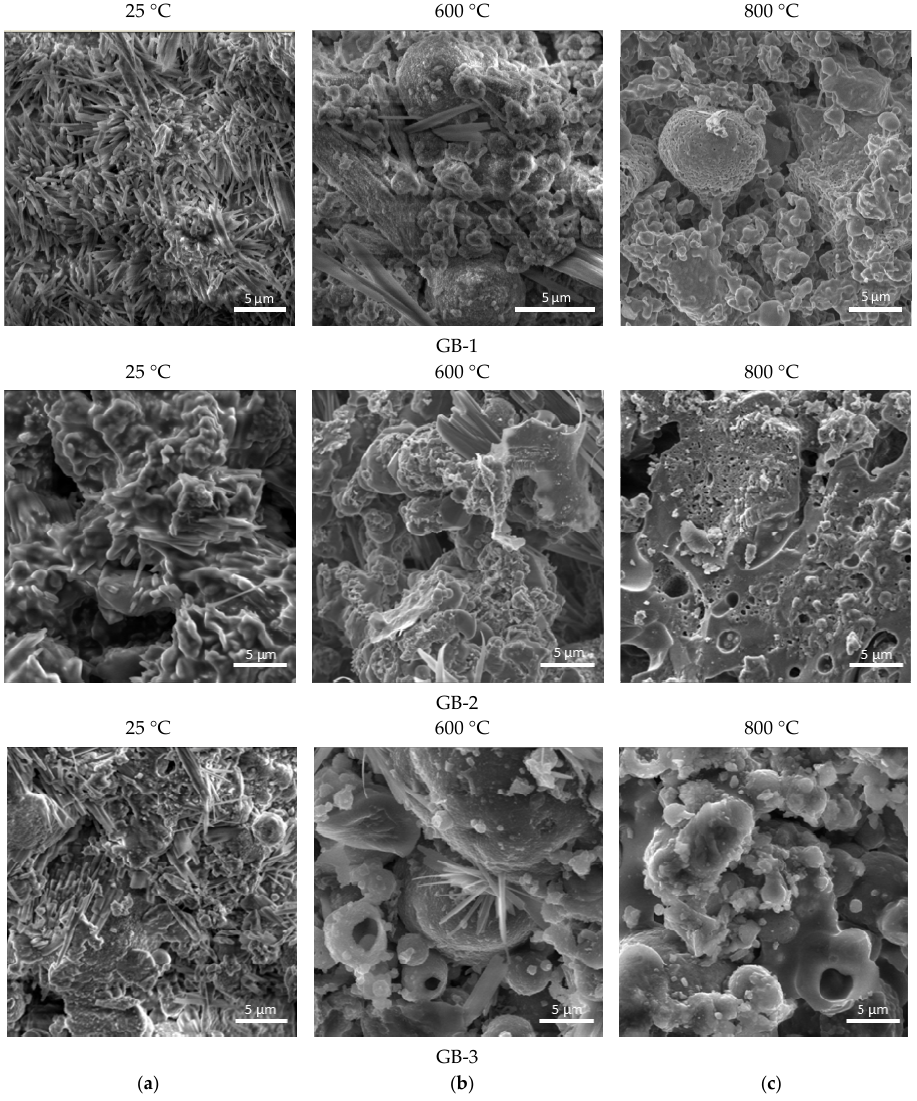
Figure 4. Micrographs of the alkali activated compositions after thermal treatment at different temperatures ( a ) 25 °С; ( b ) 600 °С; ( c ) 800 °С.